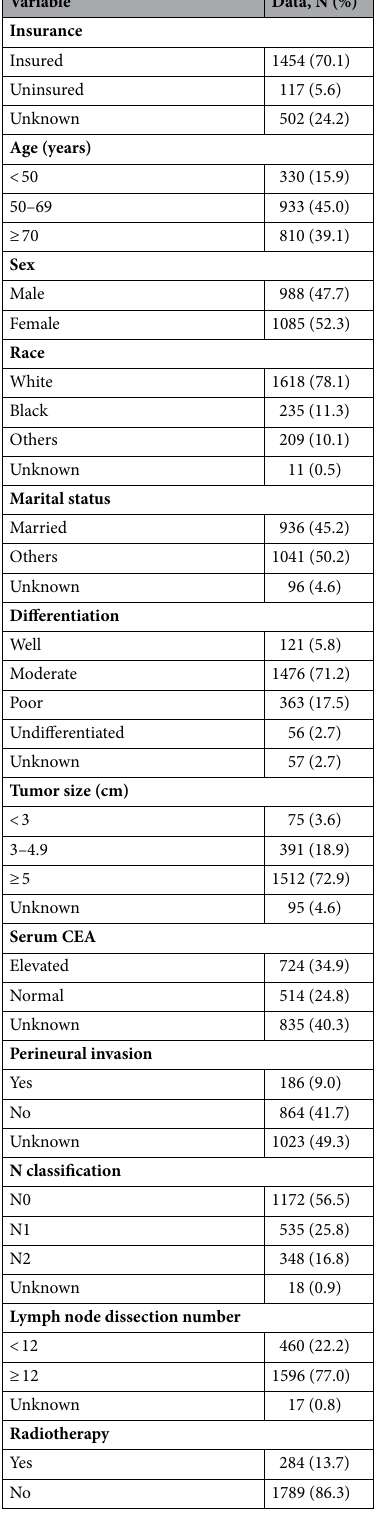
Table 1. Characteristics of patients with stage pT4b sigmoid colon cancer. N number, CEA carcinoembryonic